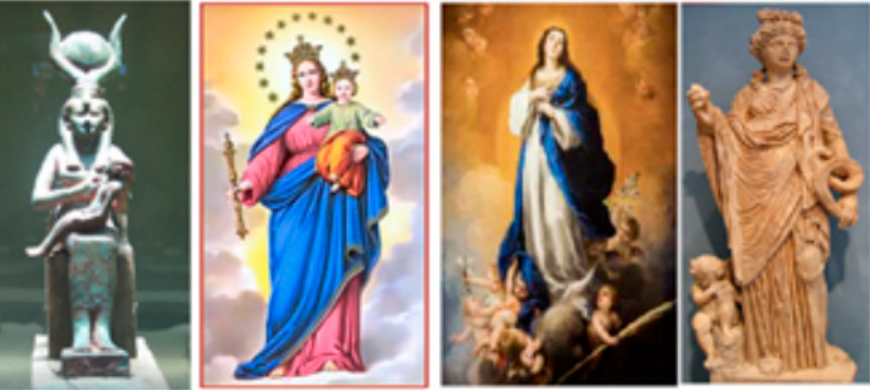
Figure 15. Isis and Mother of God versus Immaculate and